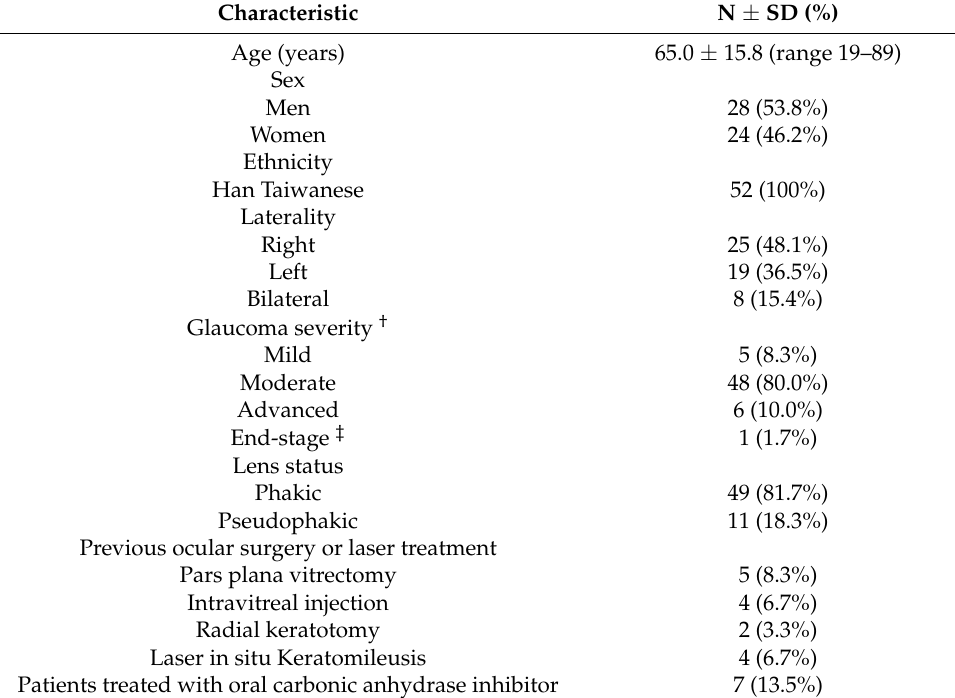
Table 1. Patient demographic and clinical characteristics.